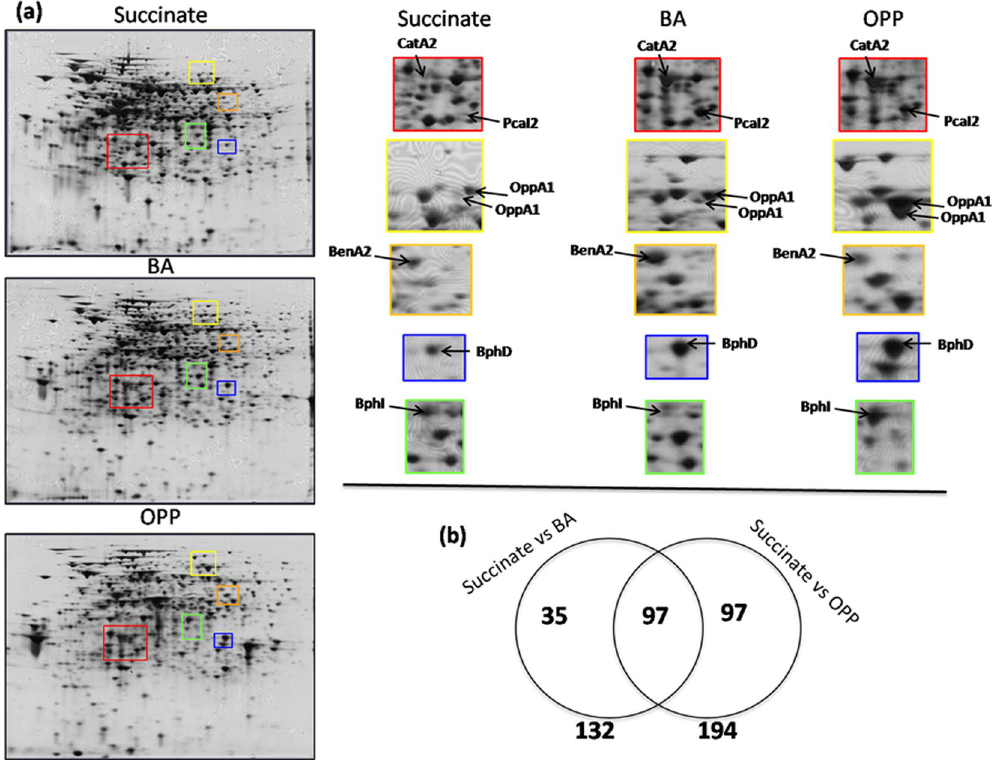
Figure 3. ( a ) 2D gels of the proteome of S. haloaromaticamans cells grown in MSMN + CA + ortho- phenylphenol (OPP), + benzoic acid (BA) or + Succinate. Colored frames on the 2D gels indicate regions where relevant catabolic proteins are located and the enlarged frames offer a focus on the intensity of spots associated to selected catabolic proteins among the different treatments; ( b ) Venn diagram representing the number of protein spots which showed differential expression in BA- vs succinate - growing cells (35) or in OPP - compared to succinate - growing cells (97). Furthermore, 97 common proteins showed differential expression in OPP- and BA-growing cells vs succinate-growing cells.